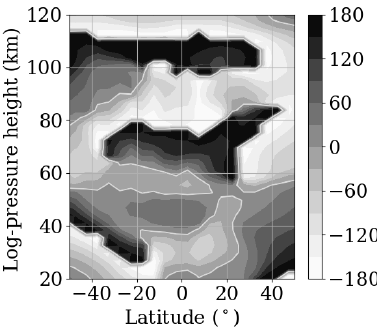
Figure 10. Altitude–latitude cross section of the MUAM SPW 1 phase extracted from the